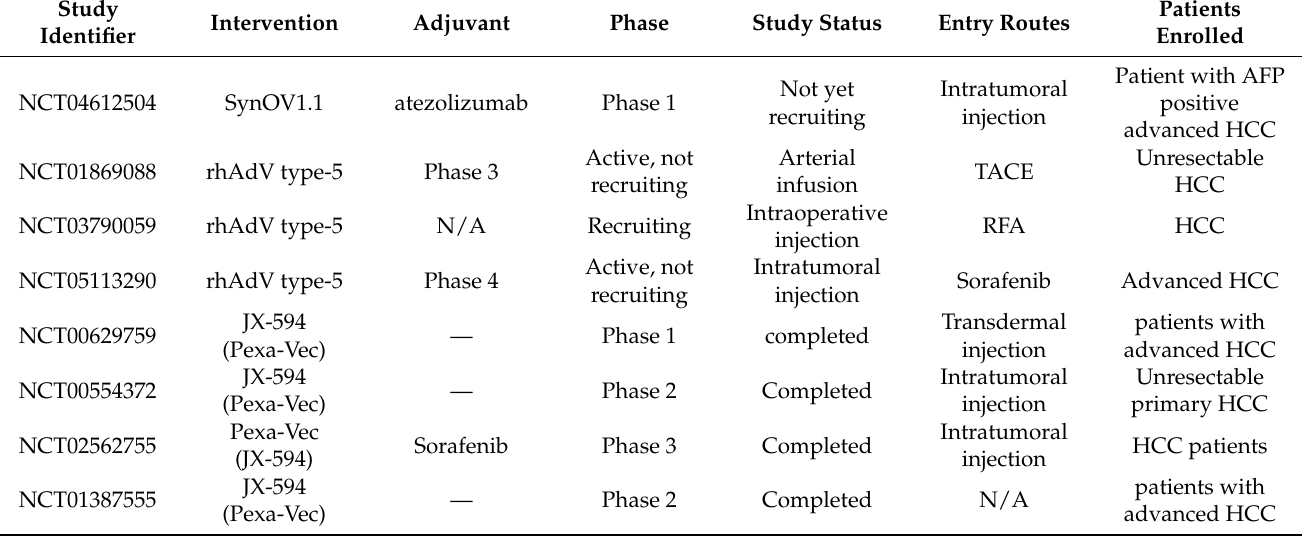
Table 2. Data from https://www.clinicaltrials.gov/ accessed on 10 May 2022 showing clinical trials of oncolytic virus mediated gene delivery for the treatment of advanced hepatocellular